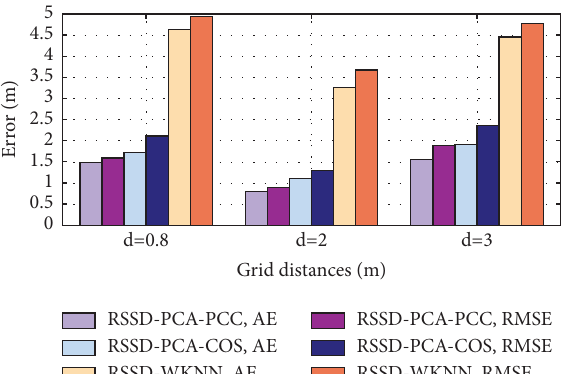
Figure 9: Error comparisons among RSSD-WKNN, RSSD-PCA-COS, and proposed RSSD-PCA-PCC with 0.8 m, 2m, and 3m grid distances, 4 APs, and K � 4.